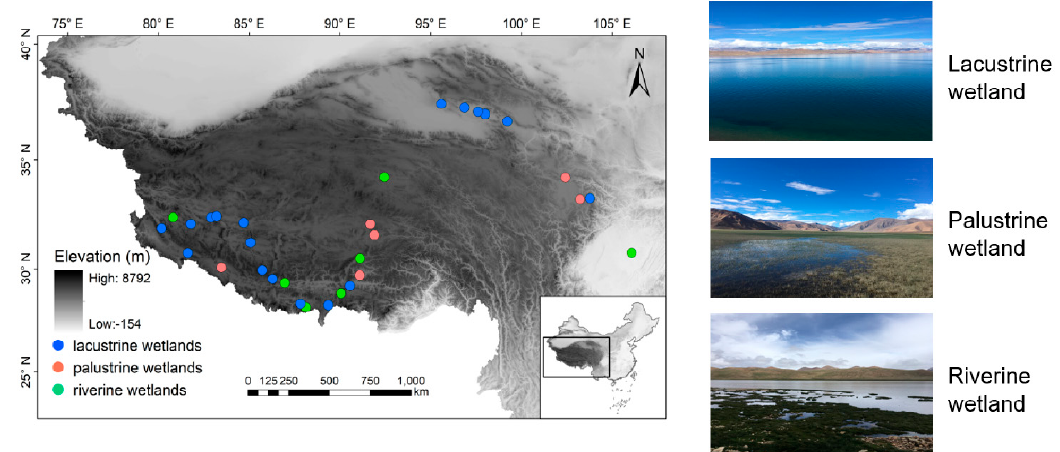
Figure 1. Location of the 31 wetlands on the Qinghai–Tibetan Plateau investigated in this study.